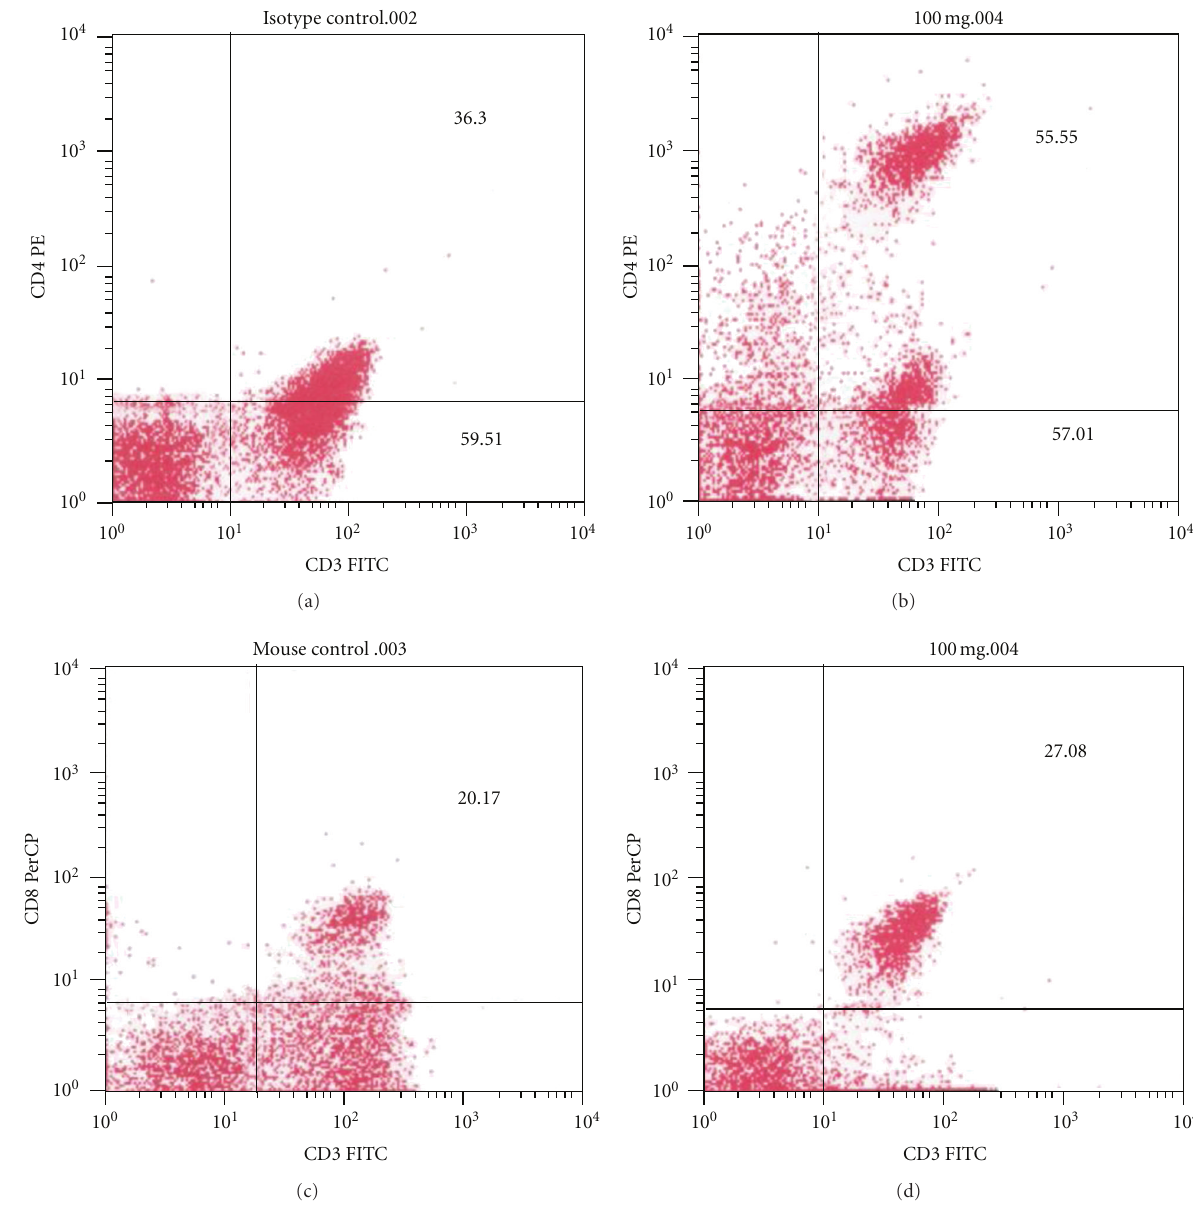
Figure 5: (a–d) E ff ect of PST001 on lymphocyte subsets by immunophenotyping. (a) CD3 and CD4 in control mice, (b) CD3 and CD4 in 100mg/kg PST001-treated mice, (c) CD8 in control mice, and (d) CD8 in 100mg/kg PST001-treated